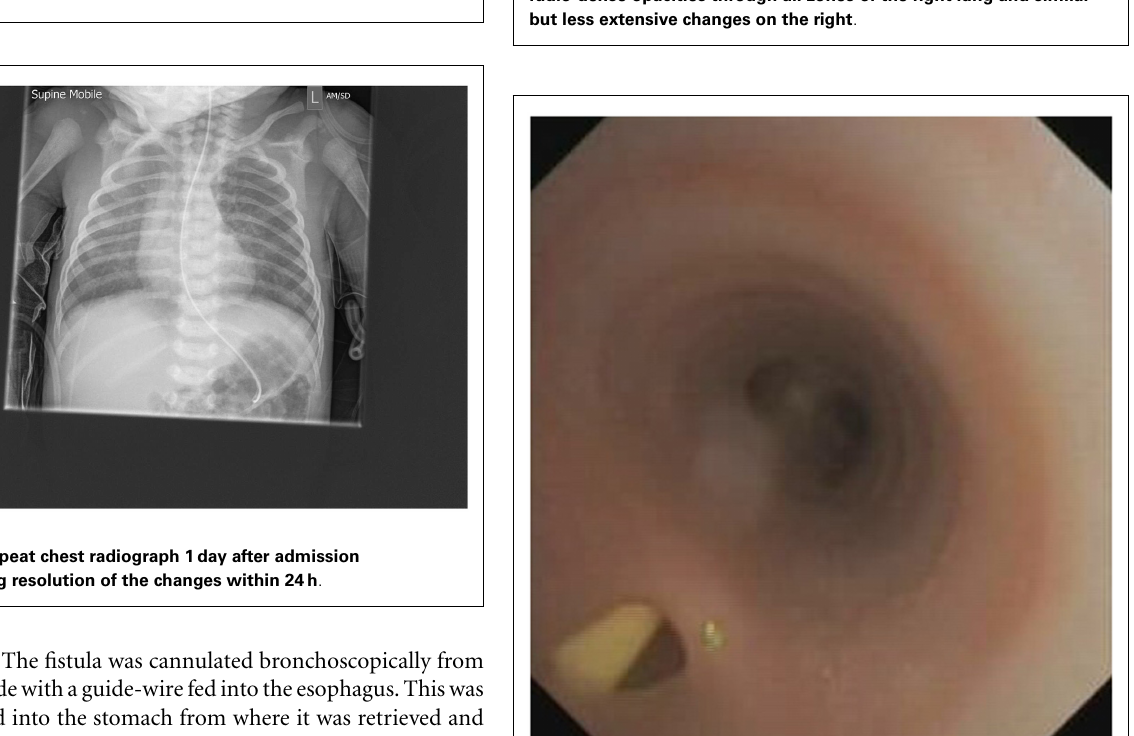
FIGURE 1 | Chest radiograph on admission showing right-sided changes .